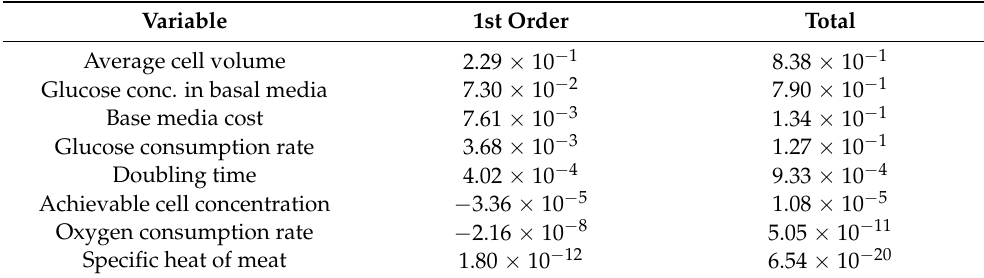
Table 8. Results of Sobol Sensitivity Analysis. AA2P, NaHCO 3 , and insulin concentration were omitted from table due to first order and total values equal to